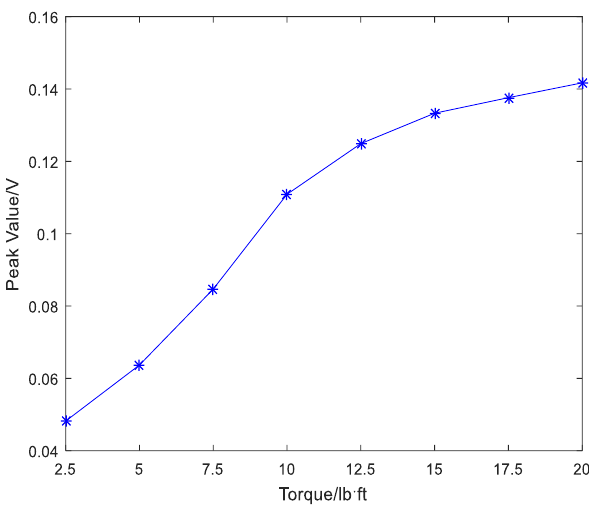
( h ) Figure 12. The focused signals based on the time reversal method at different torque levels on bar 5: ( a ) Focused signals at 2.5 lb ⋅ ft torque; ( b ) Focused signals at 5 lb ⋅ ft torque; ( c ) Focused signals at